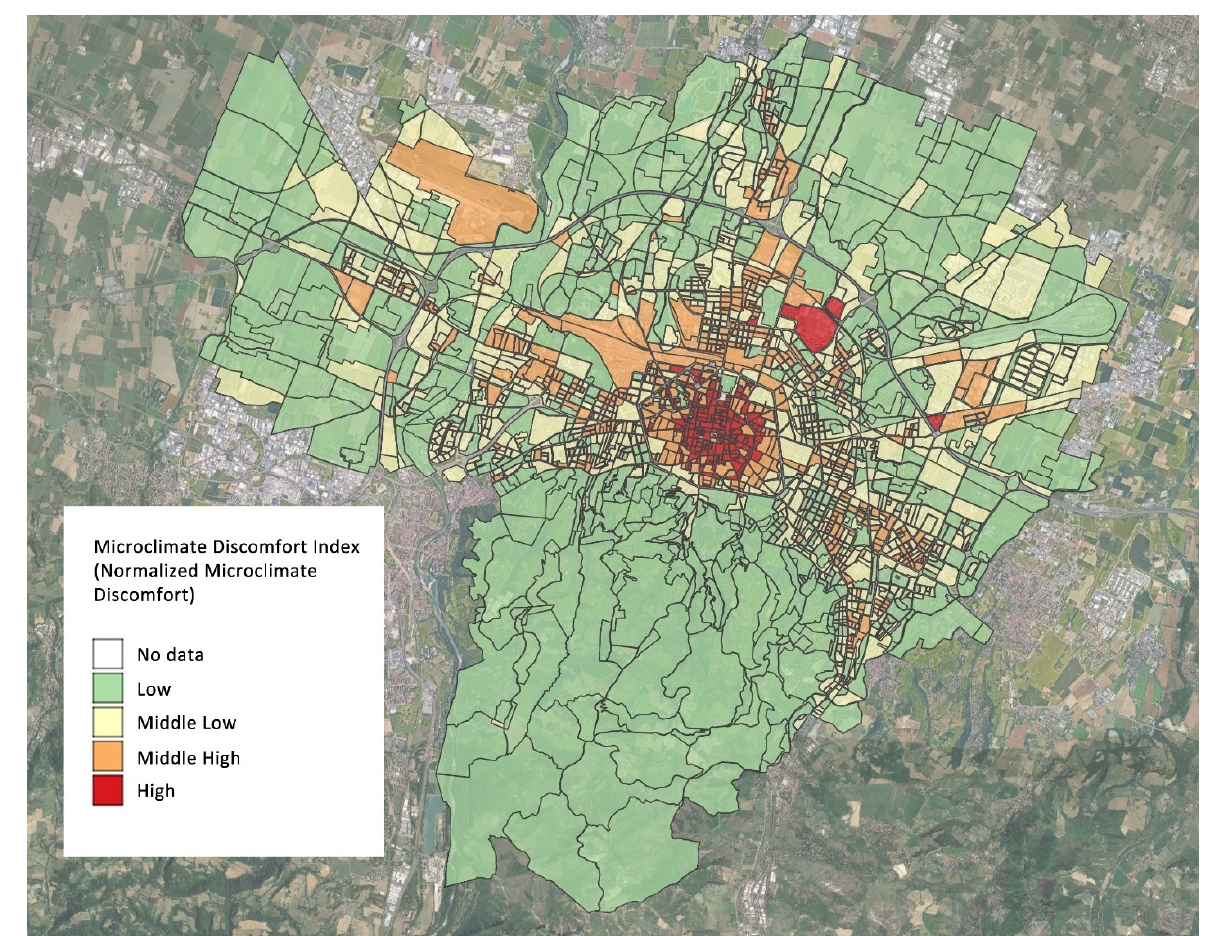
Figure 1. Map of the distribution of the microclimatic discomfort index from Nardino et al. modified [13], Bologna.